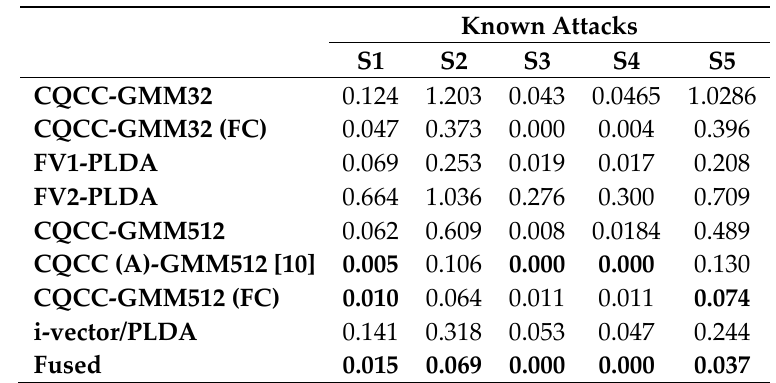
Table 4. Spoofing detection performance (in terms of EER) of all systems considered herein, including the Fisher vectors-based systems on the ASVspoof2015 evaluation set. Scores are evaluated against each spoofing attack (S1–S10) and results are reported on each of the known attacks. The lowest EERs are highlighted in bold face.